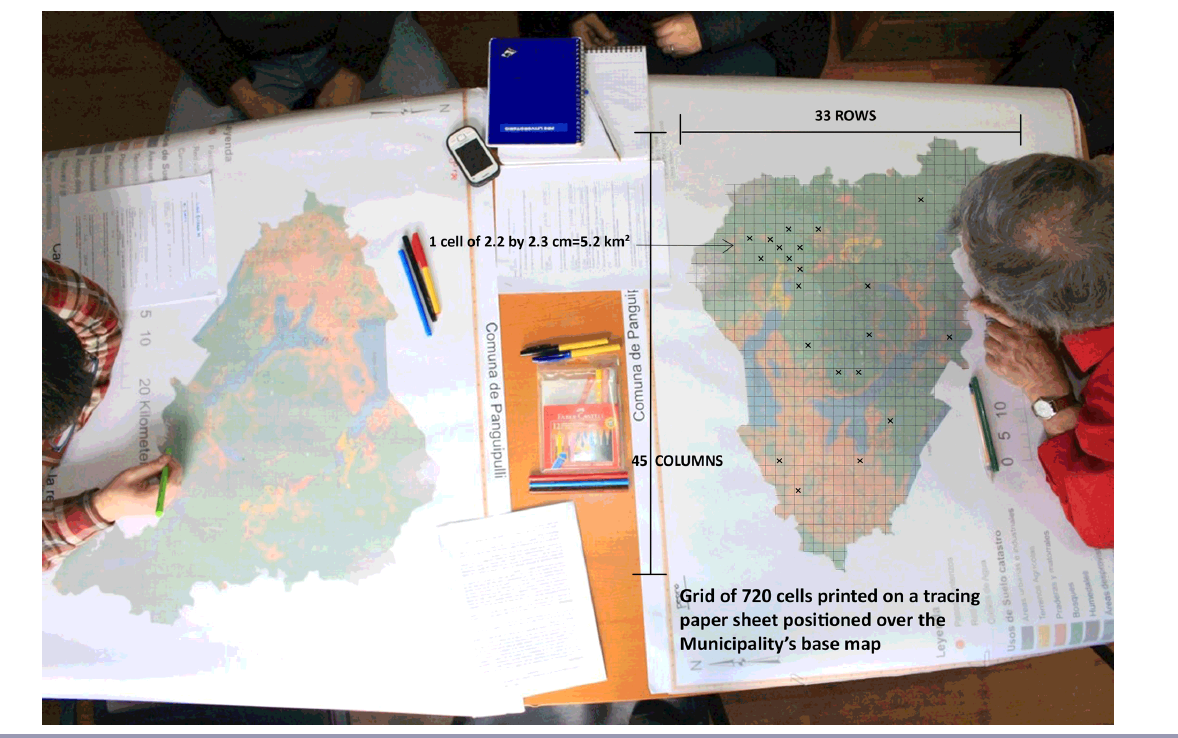
Fig. 2 . Mapping exercise showing the base map and tracing paper on which participants marked places of value of natural capital and recreational